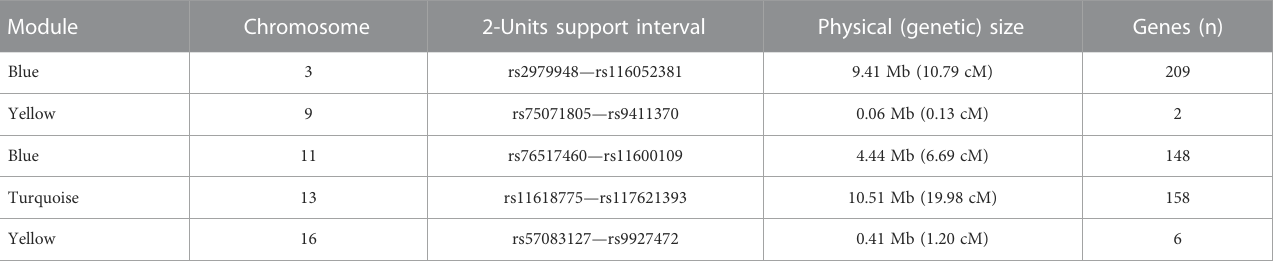
TABLE 3 Genome-wide QTL linkage analysis of microbial module QTs in IBD families. For each signi fi cantly linked locus, the 2-units support interval demarcates the chromosomal regioninwhichthe LODscore differsbyless thantwo unitsfromthe maximum LOD score.The number,n, ofgenesineachregion wasdetermined